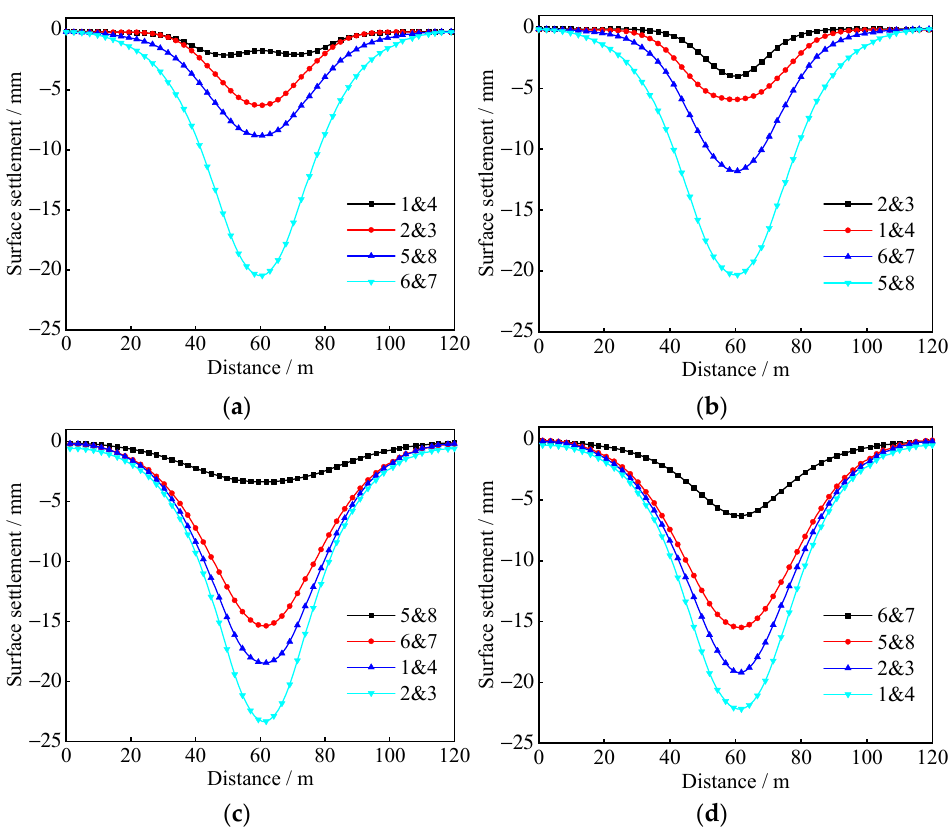
Figure 3. Ground surface settlement in the four excavation plans: ( a ) 1&4 → 2&3 → 5&8 → 6&7, ( b )